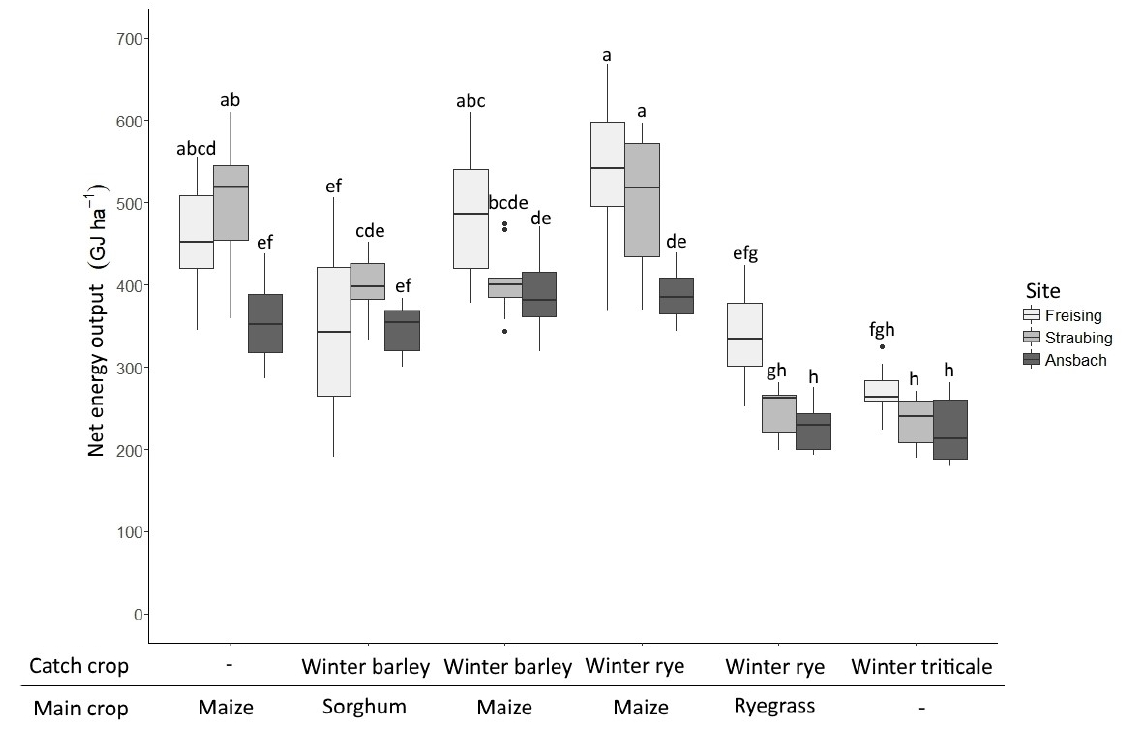
Figure 3. Mean net energy output across sites and trial years (2007–2010). Different letters indicate significant differences. Points indicate